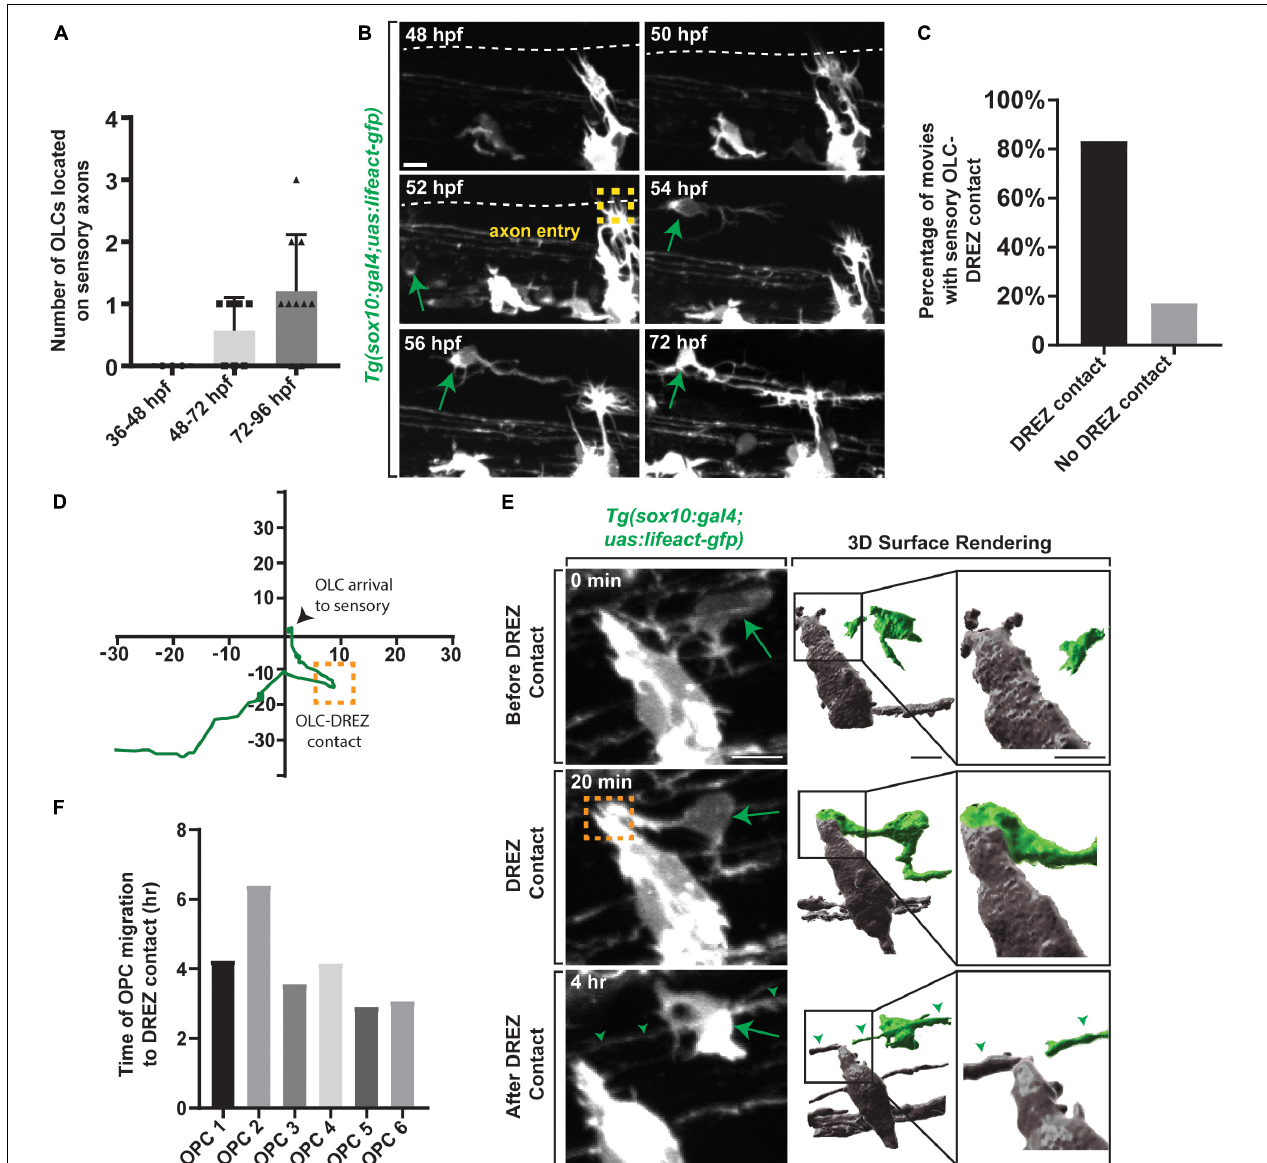
FIGURE 3 | Oligodendrocyte progenitor cells contact the DREZ immediately following axon entry. (A) Quantification of the number of OPCs located with DRG sensory nerves from 36 to 96 hpf. (B) Images from a 24 h time-lapse movie starting at 48 hpf in Tg(sox10:gal4; uas:lifeact-gfp) zebrafish showing OPC migration initiation following axon entry. Green arrow represents migrating OPC. Yellow box represents axon entry. (C) Quantification of the percentage of movies where oligodendrocytes arrived to the sensory with or without DREZ contact. (D) Migration plot of the path an oligodendrocyte traveled from the ventral spinal cord region to sensory axons. Orange box represents DREZ contact. (E) Images from a 24 h time-lapse movie starting at 48 hpf in Tg(sox10:gal4; uas:lifeact-gfp) zebrafish showing an oligodendrocyte extending a cellular process that contacts the DREZ. Green arrow represents OPC projection that contacts the DREZ. Orange box indicates OPC-DREZ contact. Green arrowheads represent the sensory axon. IMARIS 3D surface rendering of the 20 min confocal image in showing an OLC cellular process contacting the DREZ. Gray cells are DRG and peripherally located. Green cell is the sensory OL. (F) Quantification of the time it takes for an individual OPC to initiate migration post-axon entry and contact the DREZ. Scale bar equals 10 µ m (B,E) . All images are orientated anterior to left, posterior to right, dorsal up and ventral down.